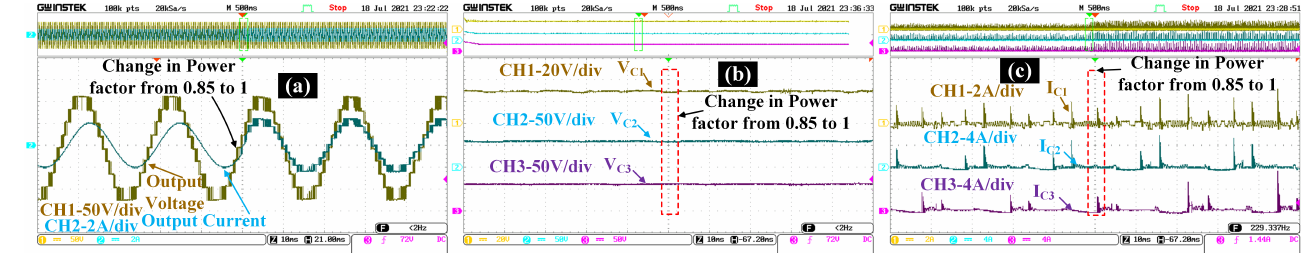
Figure 9. Experimental Results for load when power factor changes from 0.85 to 1 at V in = 30 V . ( a ) Output voltage and Output current, ( b ) Voltage across capacitor ( V C 1 , V C 2 , V C 3 ), ( c ) Capacitor current profile ( I C 1 , I C 2 , I C 3 ).